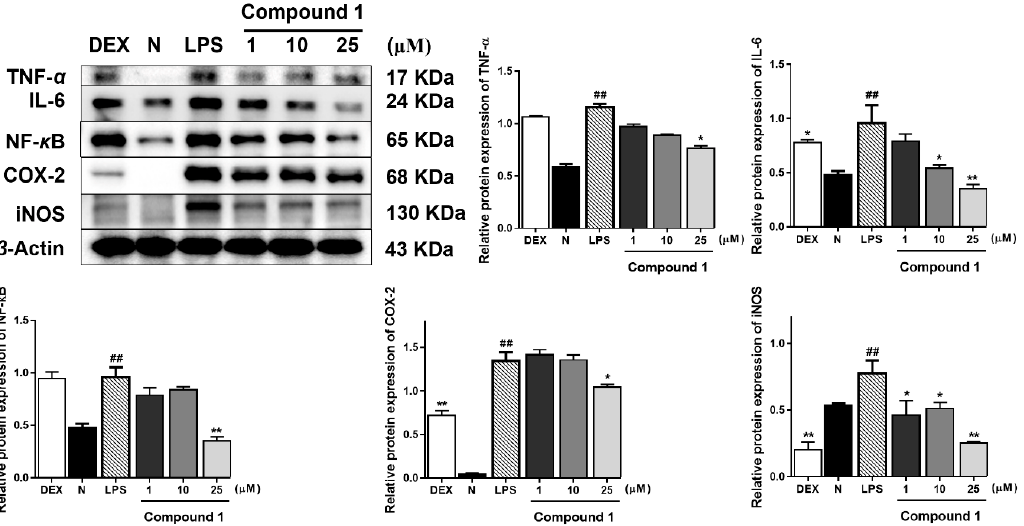
Figure 3. Inhibitory e ff ects of compound 1 on the protein expression of tumor necrosis factor-alpha (TNF- α ), interleukin-6 (IL-6), cyclooxygenase-2 (COX-2), nuclear factor kappa-B (NF- κ B), and inducible nitric-oxide synthase (iNOS) in RAW 264.7 cells. Normal: normal group without LPS, DEX, and other tested samples. Values represent the mean ± SEM of three determinations. * p < 0.05; ** p < 0.01; (Differences between compound-treated group and control group). ## p < 0.01 (Differences between LPS-treated group and control group). n = 3.